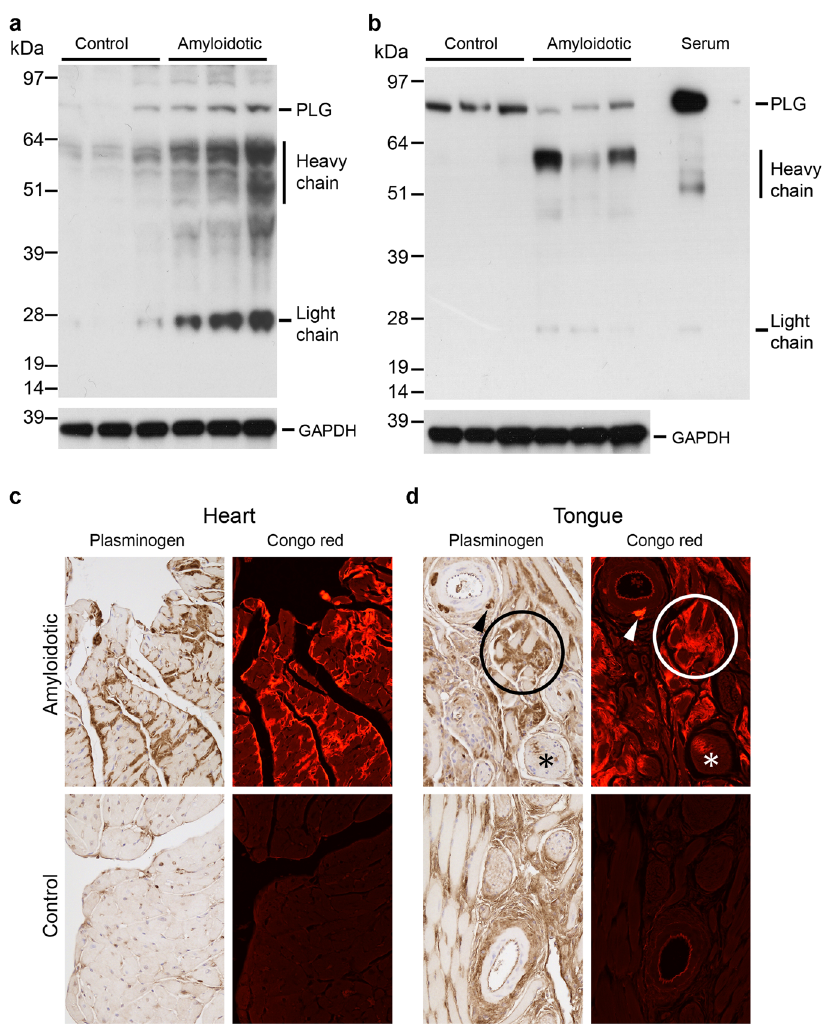
Fig. 6 Association of plasmin(ogen) with amyloid deposits. a , b Western blots probed with an af fi nity-puri fi ed anti-plasminogen (PLG) antiserum, comparing amyloidotic and control heart ( a ) and tongue ( b ) from three different mice. The amounts of plasmin heavy and light chains in amyloidotic hearts and tongues was greater than in the control tissues. GAPDH was used as a sample processing control for the tissue extracts. c , d Adjacent tissue sections of heart ( c ) or tongue ( d ) of amyloidotic and control non-amyloidotic mice were probed with an af fi nity-puri fi ed anti-plasminogen antiserum, or stained with Congo red. c In amyloidotic heart, the pattern of immunoreactivity closely parallels the distribution of amyloid deposits. In control heart, the signal is much lower and almost exclusively within the vasculature. d In control tongue, moderate immunoreactivity is evident in connective tissue, consistent with the presence of plasminogen in the extracellular space. In amyloid-containing tongue, additional strong immunoreactivity was evident in the same distribution as the amyloid seen here, for example, surrounding muscle fi bres (circled), in the adventitia of an arteriole (arrowhead), and within a small nerve (asterisk). Images in c and d are representative of fi ndings in three different mice. Scale bar: 100 µ m. Source data are provided as a Source Data fi